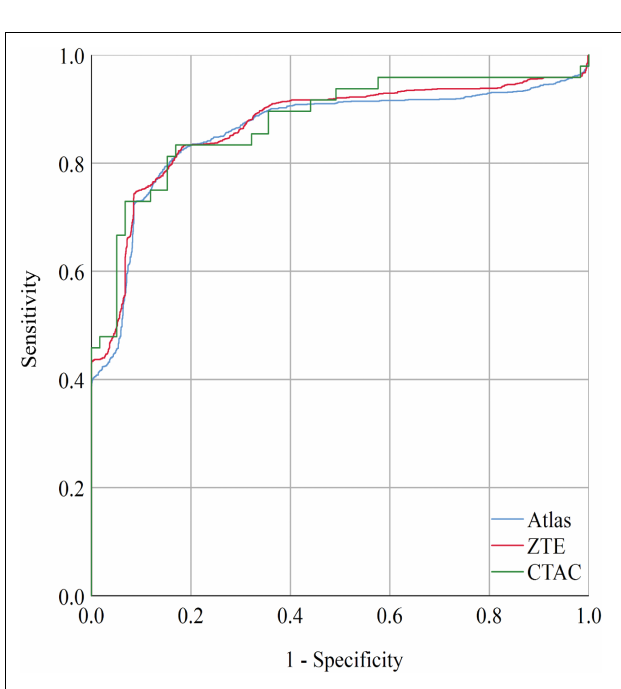
FIGURE 3 | When setting the cut-off value to PETscore ZTE = 1.143, the sensitivity and specificity were 75 and 91% with AUC = 0.870 (CI: 0.855–0.884). When setting the cut-off value to PETscore Atlas = 0.924, the sensitivity and specificity were 81 and 84% with AUC = 0.859 (CI: 0.844–0.875). The AUC of CTAC was 0.876 (CI: 0.862–0.890). AUC, area under curve.